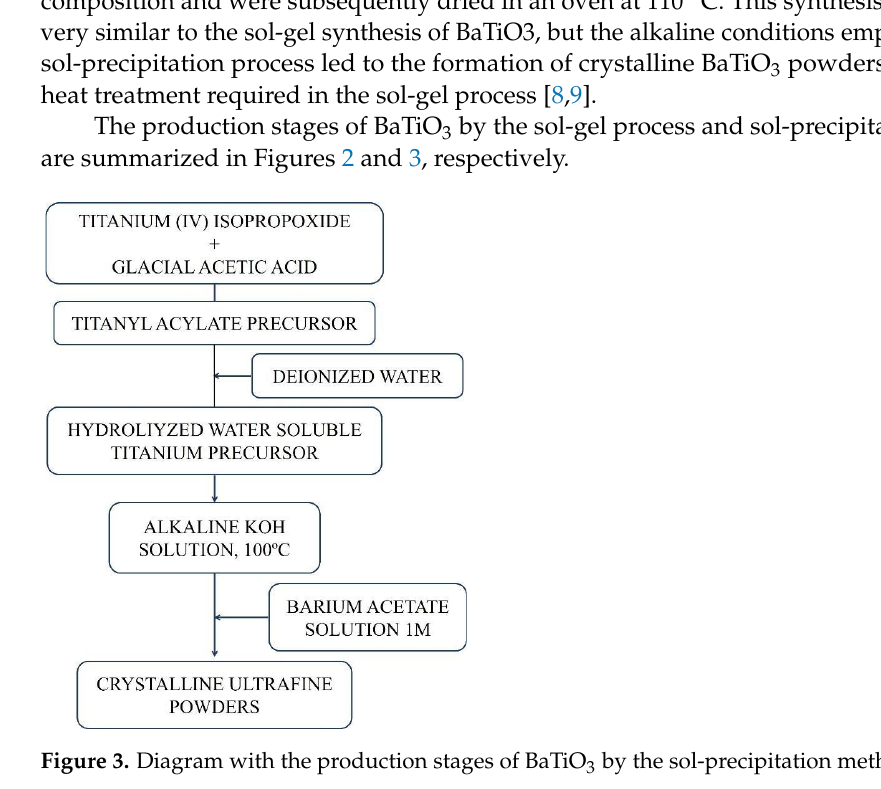
3 by the sol-precipitation